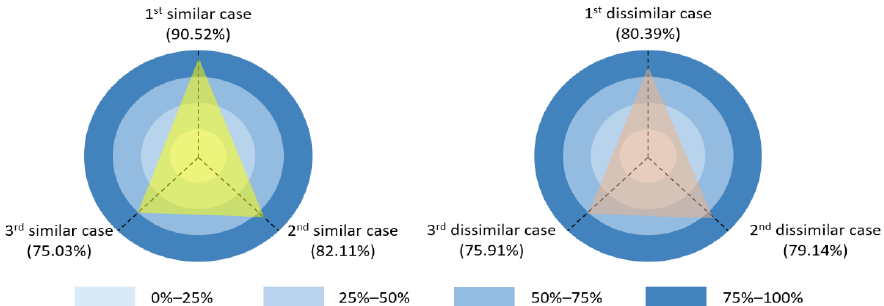
Figure 8. The average precision of retrieved top three similar and dissimilar past cases (without retaining new